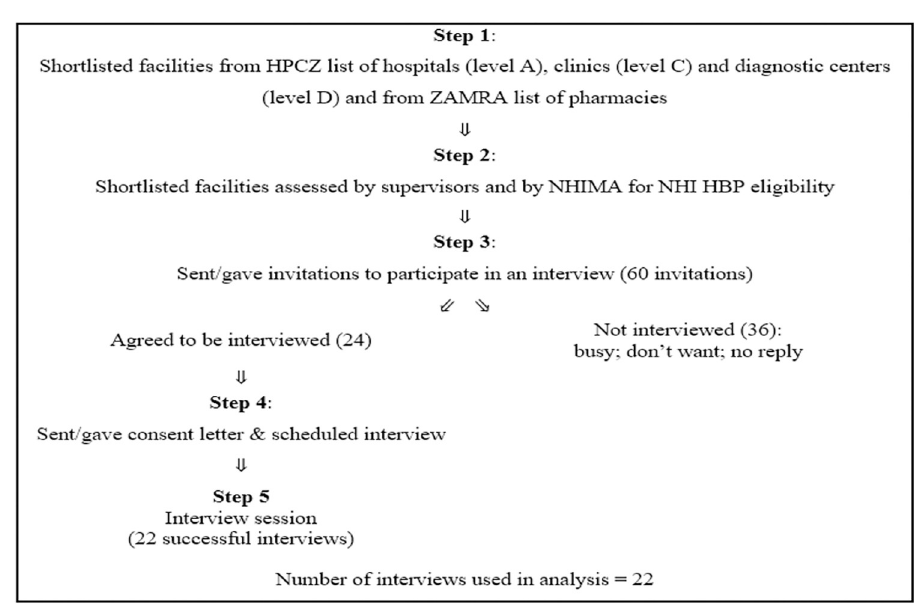
Fig 2. Process for stratified purposeful sample